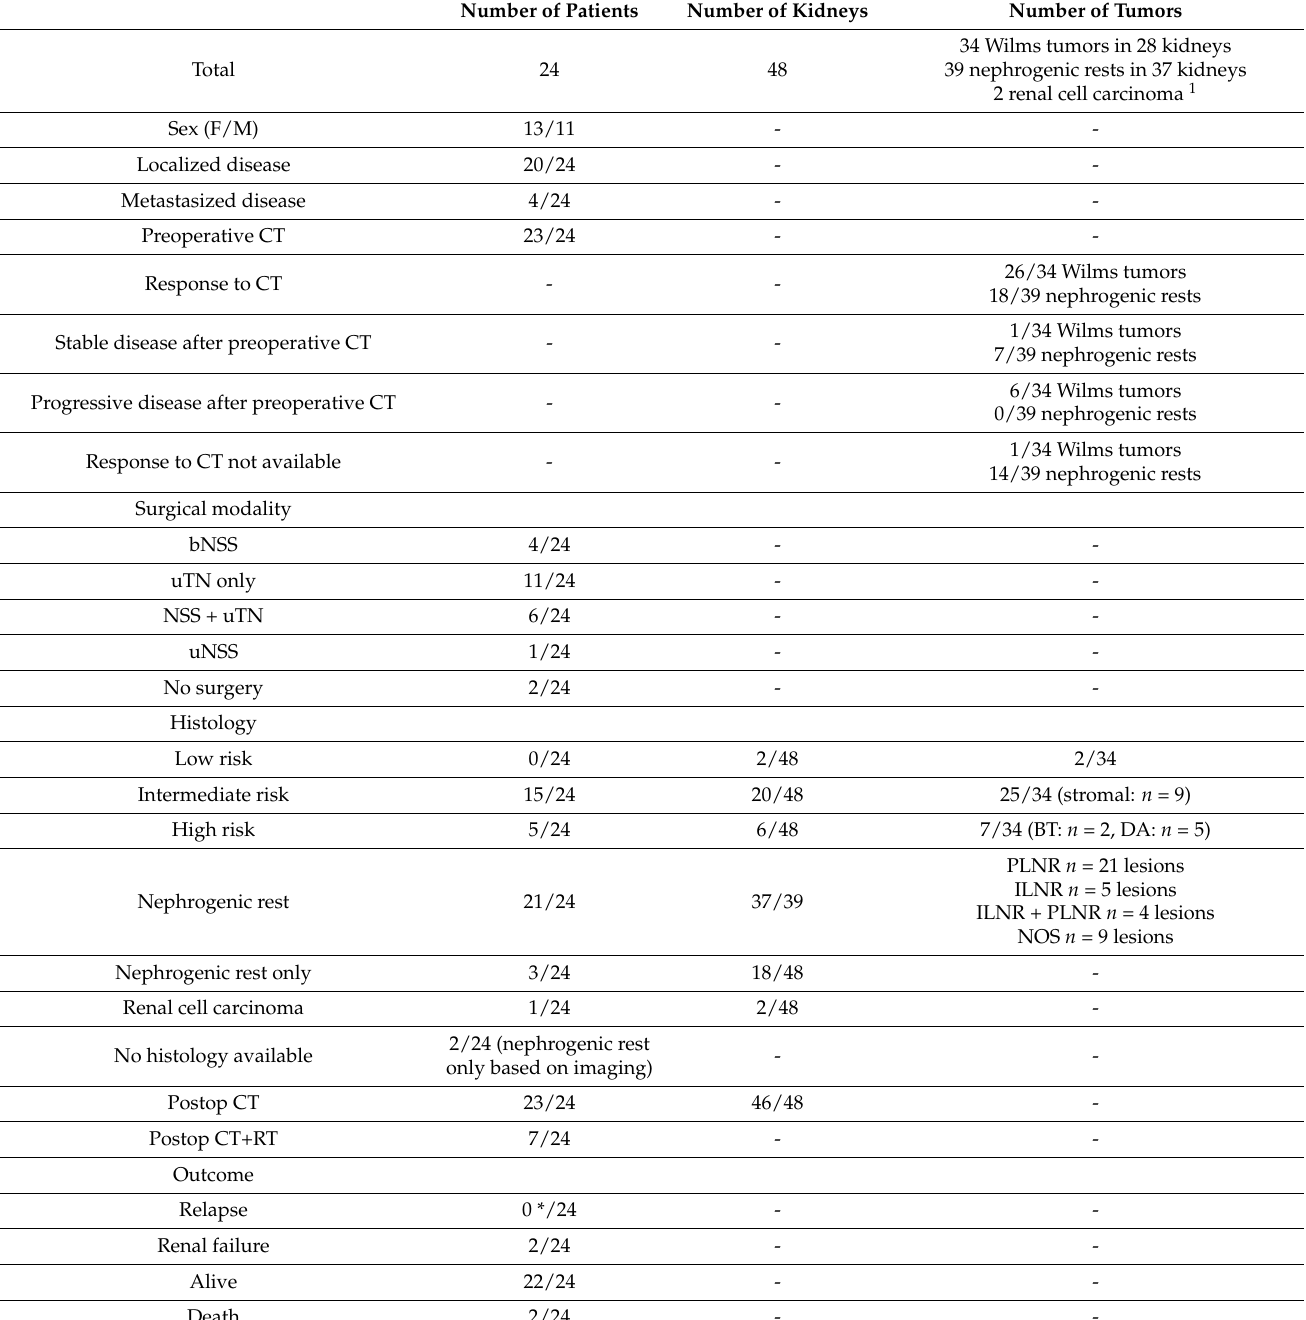
Table 1. Summary of clinical information of 24 bilateral renal tumor